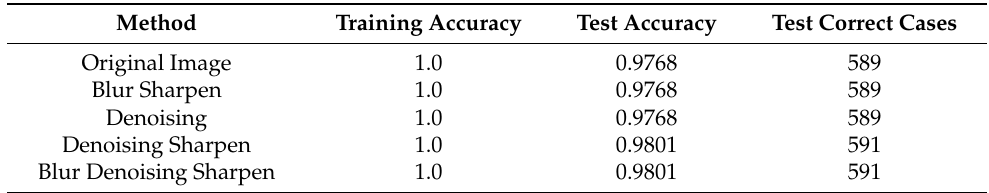
Table 3. Effect of image denoising methods on WHU-RS19 dataset.